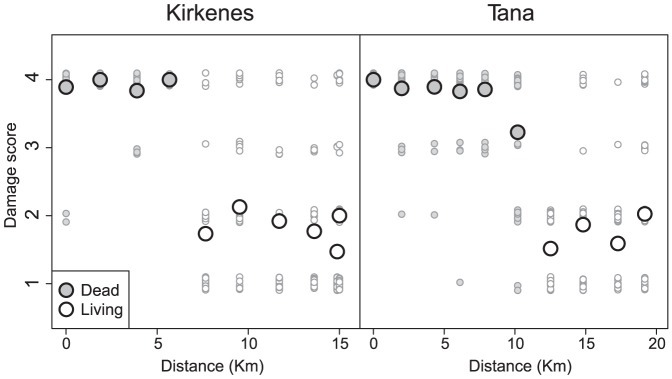
Station-specific damage scores of birch stems along the two sampling transects.The X axes represent the airline distances from the first sampling station in each transect. Large circles represent mean damage scores for each station, while small circles represent scores for individual stems. A small amount of noise has been added to the stem-specific scores to help distinguish individual datapoints. See table 1 for explanation of damage scores.